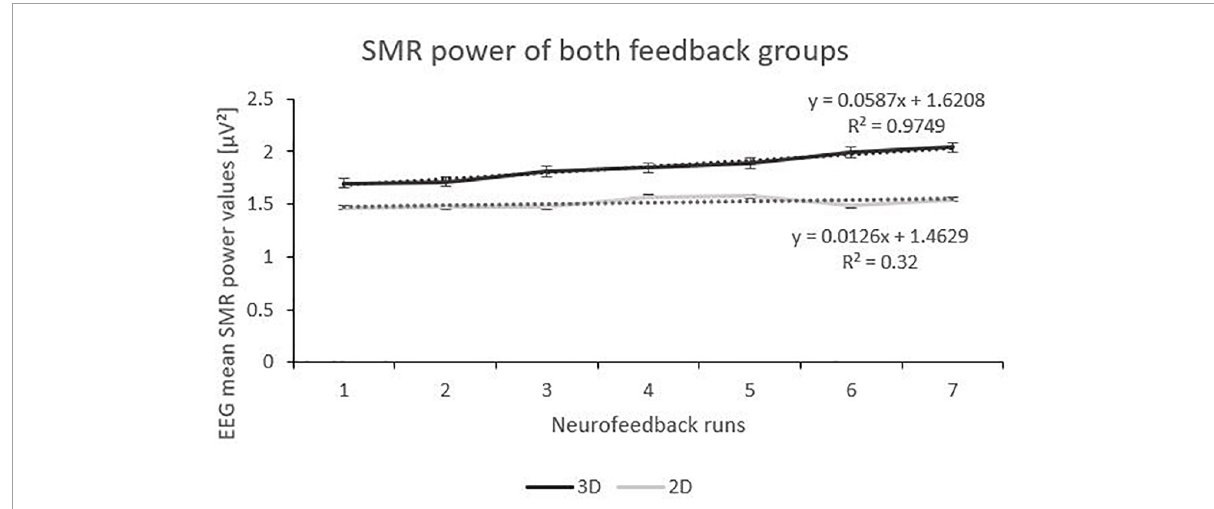
FIGURE2 Trend of SMR Power over the Feedback Runs for 3D and 2D Groups with the linear trendlines of each group. R 2 represents the respective explained variance of SMR power. Error Bars show Standard Error.